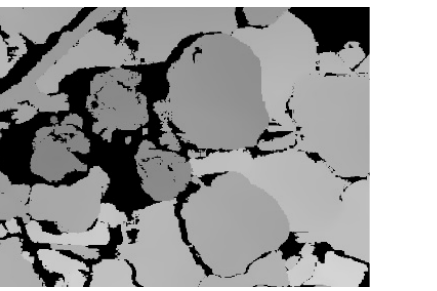
Figure 10. Detection process of the grasping angle.